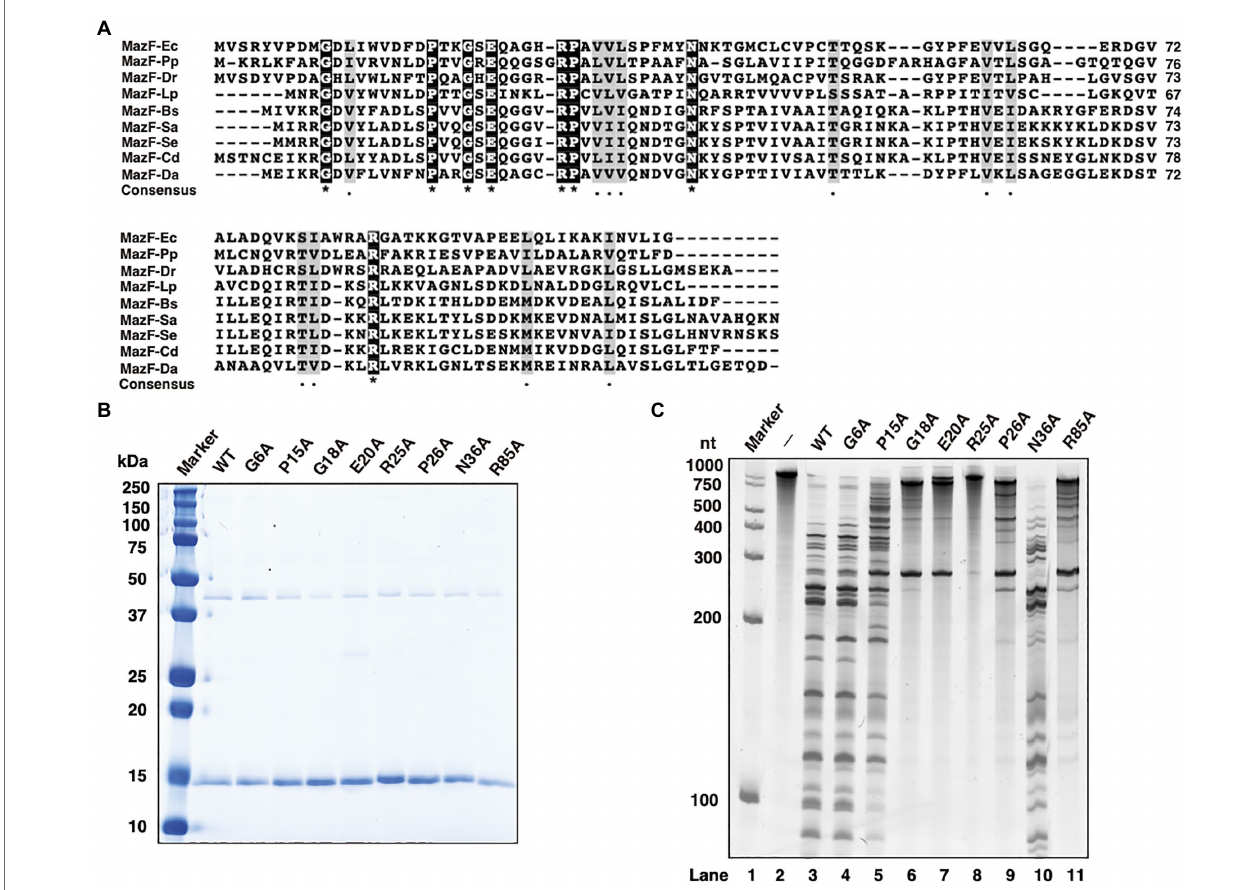
FIGURE 5 | Characterization of MazF-Da mutants. (A) The amino acid sequences of MazF-Da and various MazFs were aligned as described below; Ec: Escherichia coli , Pp: Pseudomonas putida , Dr.: Deinococcus radiodurans , Lp: Legionella pneumophila, Bs: Bacillus subtilis, Sa: Staphylococcus aureus , Se: Staphylococcus equorum , Cd: Clostridium difficile , and Da: Candidatus Desulforudis audaxviator. Black squares indicate a perfect amino acid match and gray squares indicate a high degree of amino acid similarity. Asterisks indicate 100% identity between the nine sequences and dots indicate 80% similarity between the nine sequences. (B) The molecular weight and purity of the wild-type MazF-Da (WT) and of the MazF-Da mutants (G6A, P15A, G18A, E20A, R25A, P26A, N36A, and R85A) obtained using a cell-free protein synthesis system were analyzed using SDS-PAGE and visualized using CBB staining. (C) After the reaction of each MazF-Da mutant with the substrate RNA, the resultant digested RNA fragments were analyzed using urea gel. Lane 1, marker; lane 2, negative control without enzyme; lanes 3, wild type; lane 4, G6A; lane 5, P15A; lane 6, G18A; lane7, E20A; lane 8, R25A; lane 9, P26A; lane 10, N36A; lane 11,